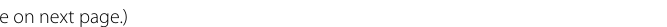
figure on next Fig. 1 HIV exposed uninfected infant cord blood displays elevated cytokines consistent with inflammation and immune stimulation compared to HIV unexposed infant cord blood. Cytokines were detected in samples from all maternal delivery plasma and infant cord blood plasma using multiplexed Luminex Elisa bead‑based technology. Assays at or below the lower limit of detection were assigned the lowest limit of detection. Individual plasma concentration ( ln pg/ml), group median and IQR are plotted. Related sample medians (HEU vs HIV HIV mother, n 19 pairs) were compared using Wilcoxon Rank Sum test while independent medians were compared using Mann–Whitney U test − = (HEU vs HU). Symbols are as follows: HIV women filled squares, HU infants open squares, HEU infants open circles, HIV −